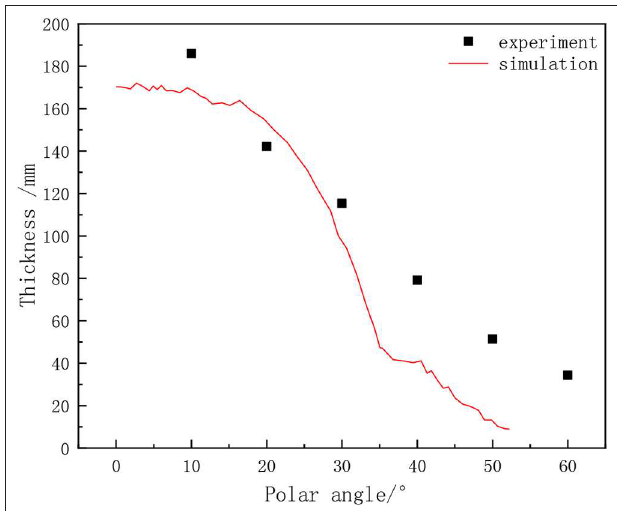
FIGURE 6 | Comparison of experimental and simulated